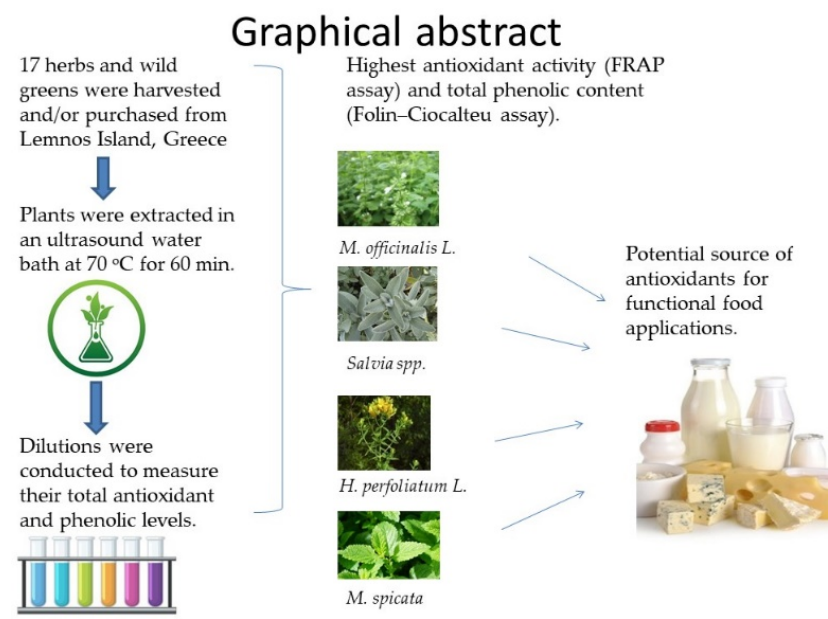
Figure 1. Graphical scheme of the study design.